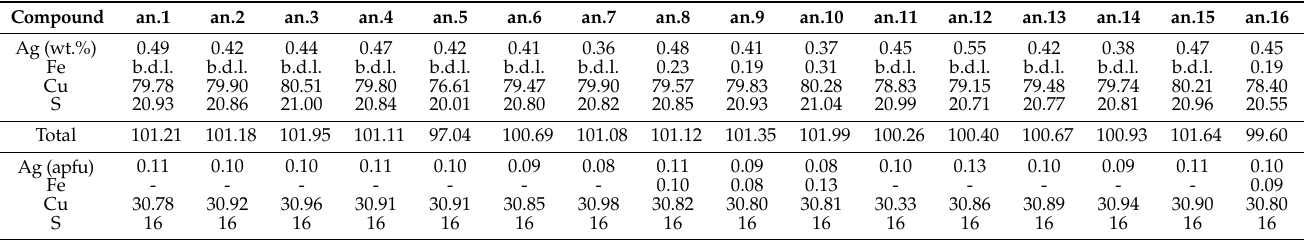
Table 2. Selected representative electron microprobe analyses of djurleite from the Lubin mine, Poland. Crystal chemical formulae recalculated on basis of 16 S 2 − . Compound